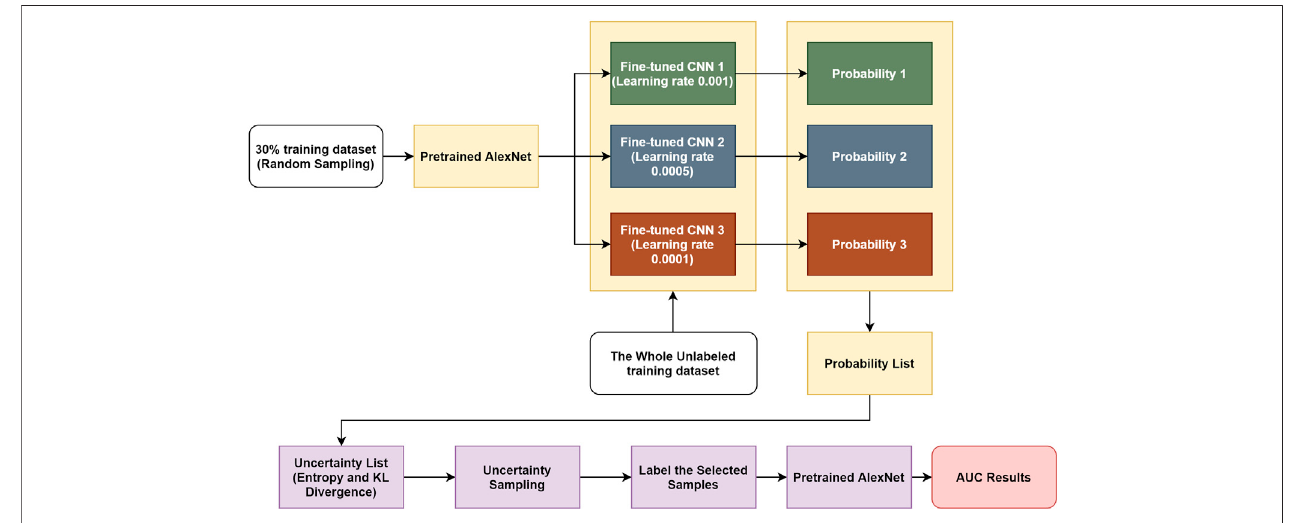
FIGURE 1 | Work fl ow of proposed transfer learning – based active learning